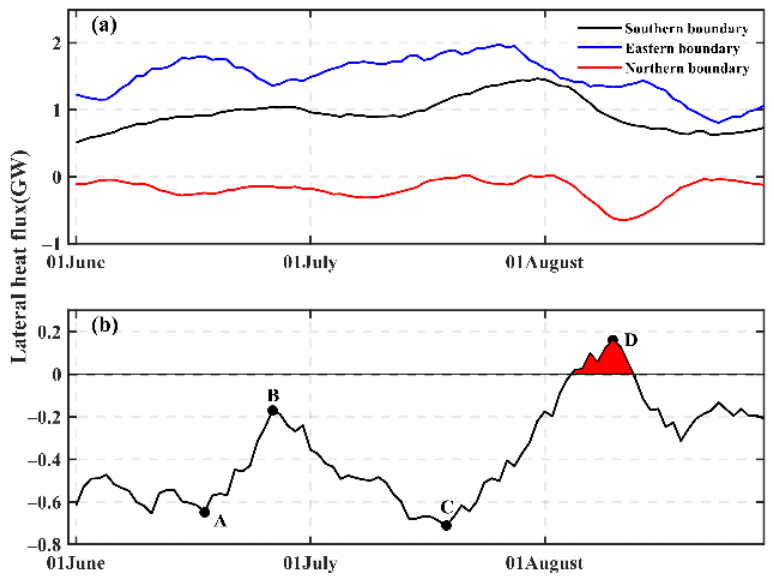
Figure 8. Lateral heat fluxes from June to August 2021 (unit: GW). ( a ) Heat fluxes across the northern (red line), southern (black line), and eastern boundaries (blue line). ( b ) Total heat flux across the three boundaries, with positive values representing regional heat accumulation (red–shaded area). The four points A, B, C, and D in ( b ) are the time nodes of increasing heat